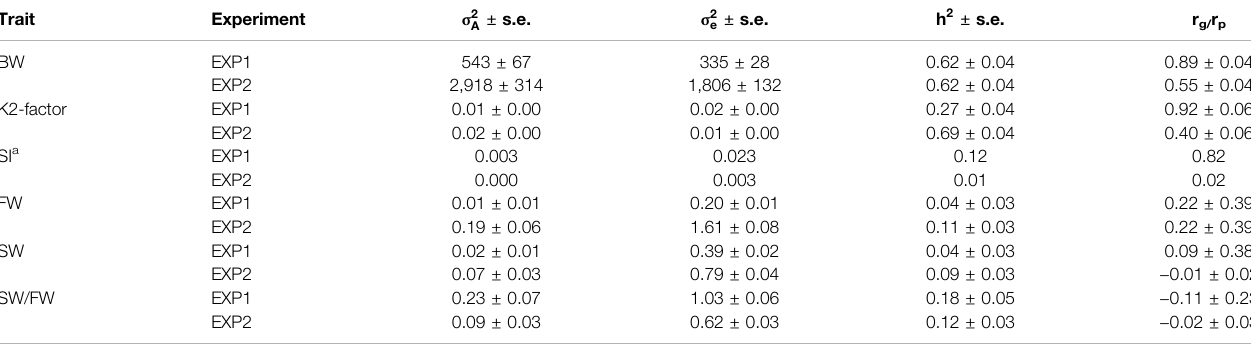
TABLE 3 | Estimates of additive genetic and residual variances and heritability from bivariate models of the same trait in EXP1 and EXP2, and the genetic (r g , upper line for each trait) and phenotypic (r p , lower line for each trait) correlation between the same trait in the two experiments. Trait Experiment